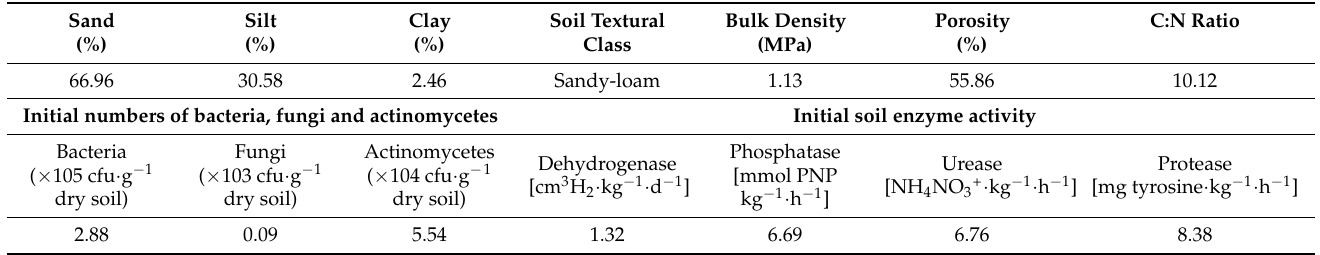
Table 4. Initial physico-chemical properties and microbiological and enzymatic activity of soil of the study site.